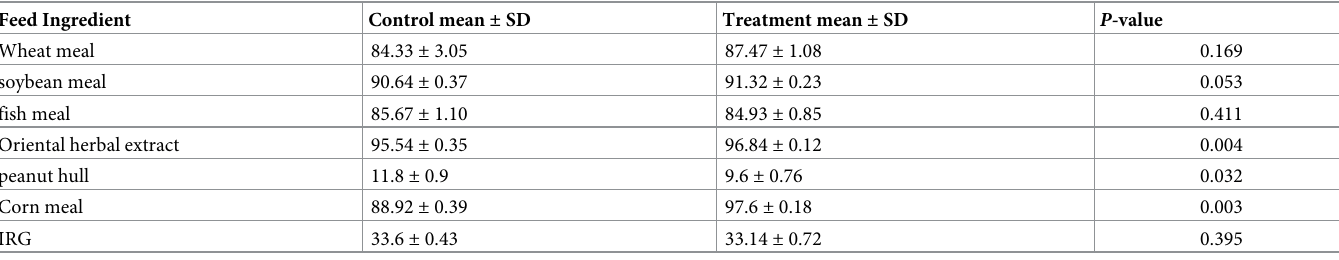
Table 3. IVTTD of feed ingredients (values are mean ± standard deviation, n = 3). Feed Ingredient